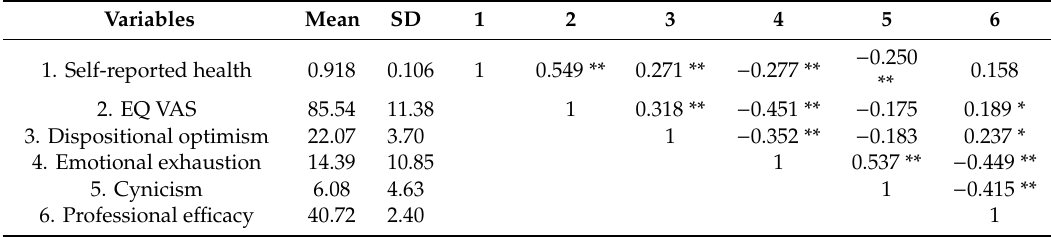
Table 3. Dispositional optimism, burnout and self-reported health ( n = 109).